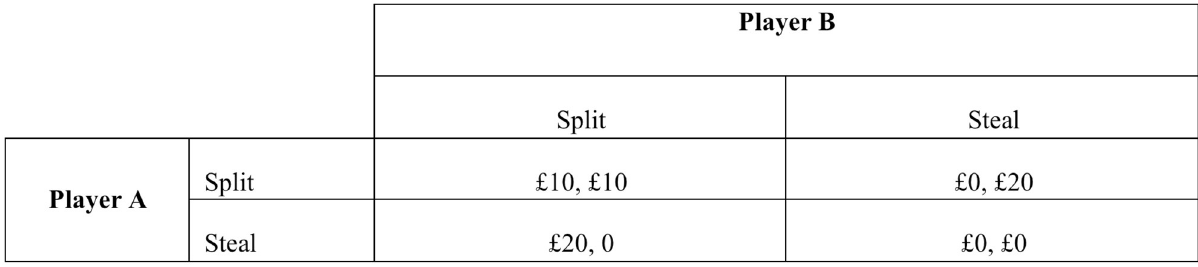
Fig 1. Golden Balls game payoff